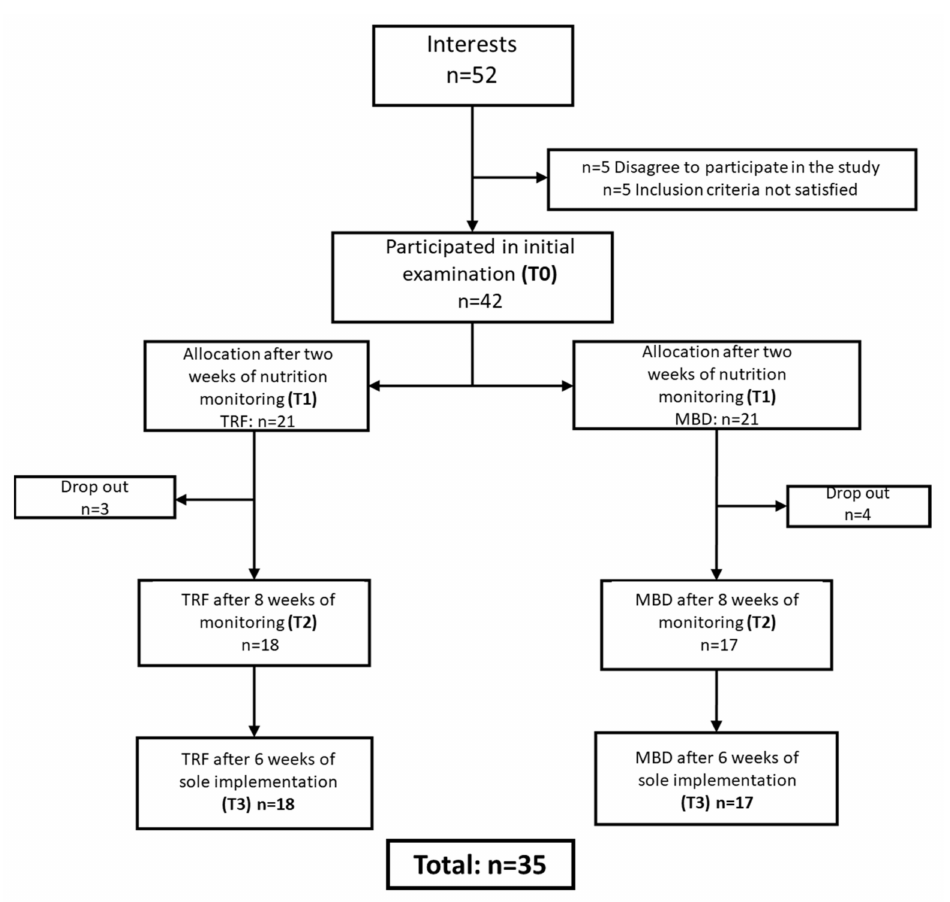
Figure 2. Flow diagram of inclusion and dropout of participants for